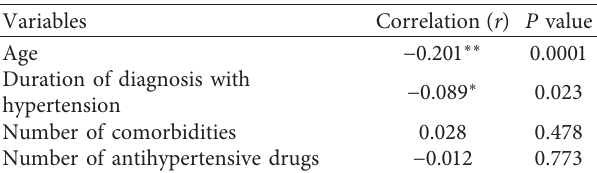
Table 5: Correlation of the total HILL-BONE CHBPTS score with variables of hypertensive